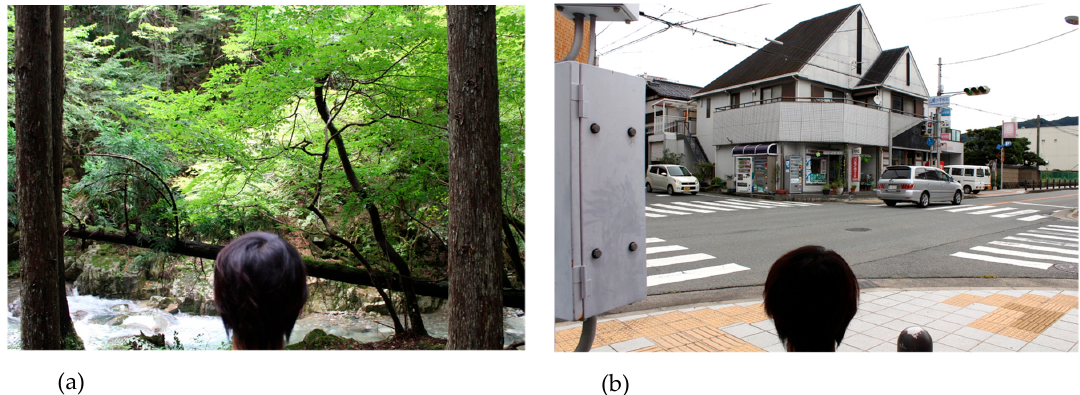
Figure 1. Viewing a forest area ( a ) and a city area ( b ).